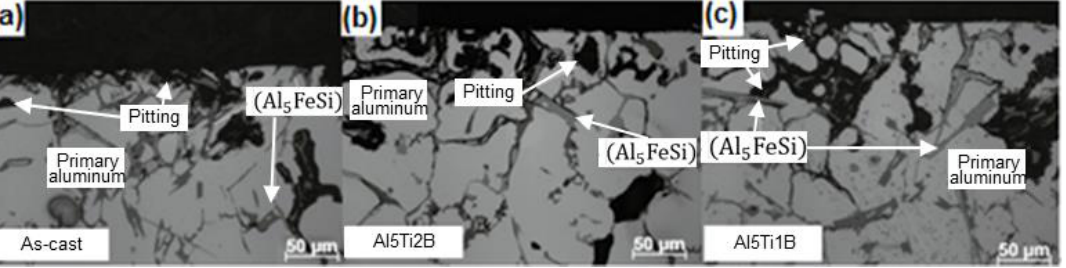
Figure 16. Optical micrographs of cross-section from ( a ) as-cast condition without grain refiner; ( b ) grain refiner Al5Ti2B; ( c ) grain refiner Al5Ti1B 500×. Table 5. Corrosion results for different conditions.